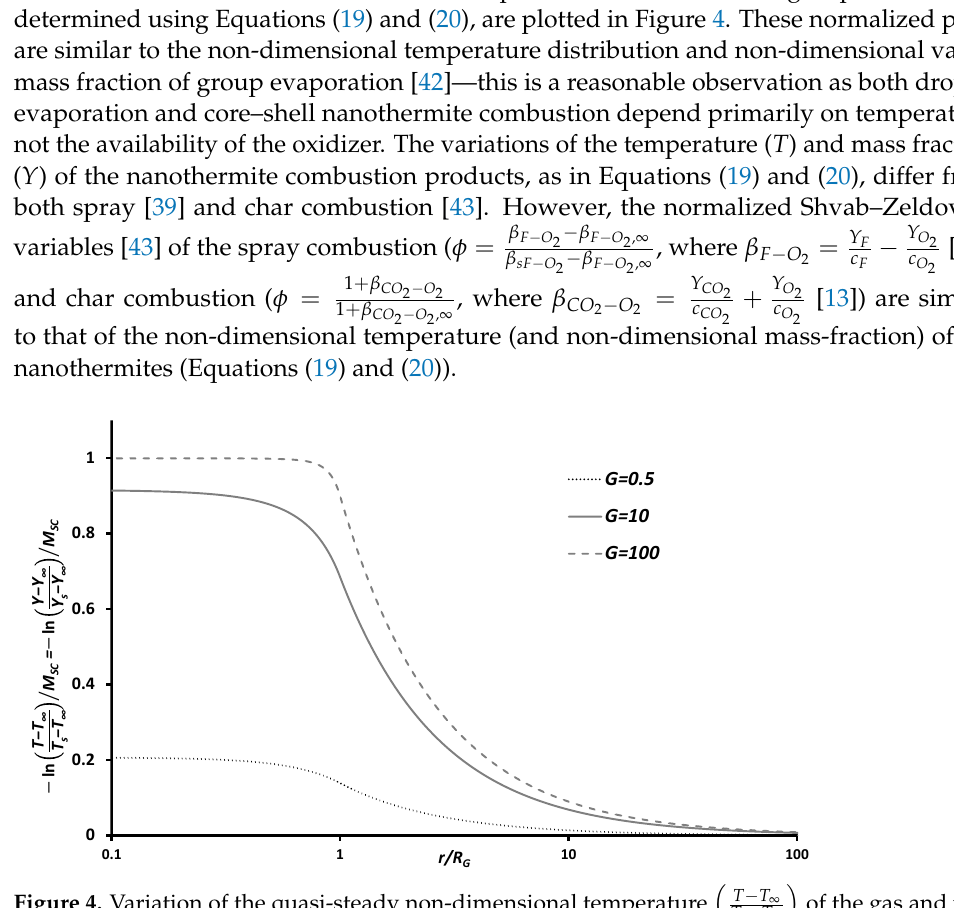
(cid:16) (cid:17) Y − Y ∞ of copper vapors with a non-dimensional radius Y s − Y ∞